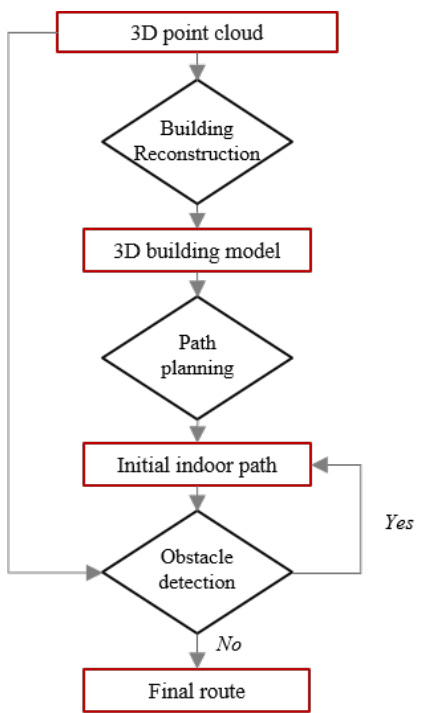
Figure 1: General workflow of the proposed methodology.